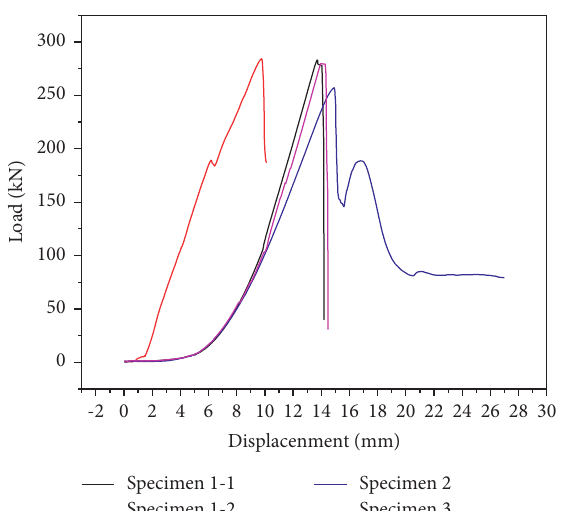
Figure 5: The push-out test specimen load-displacement curves. Note. Specimen 1-1 means the first load of specimen 1; specimen 1-2 means the second load of specimen 1.